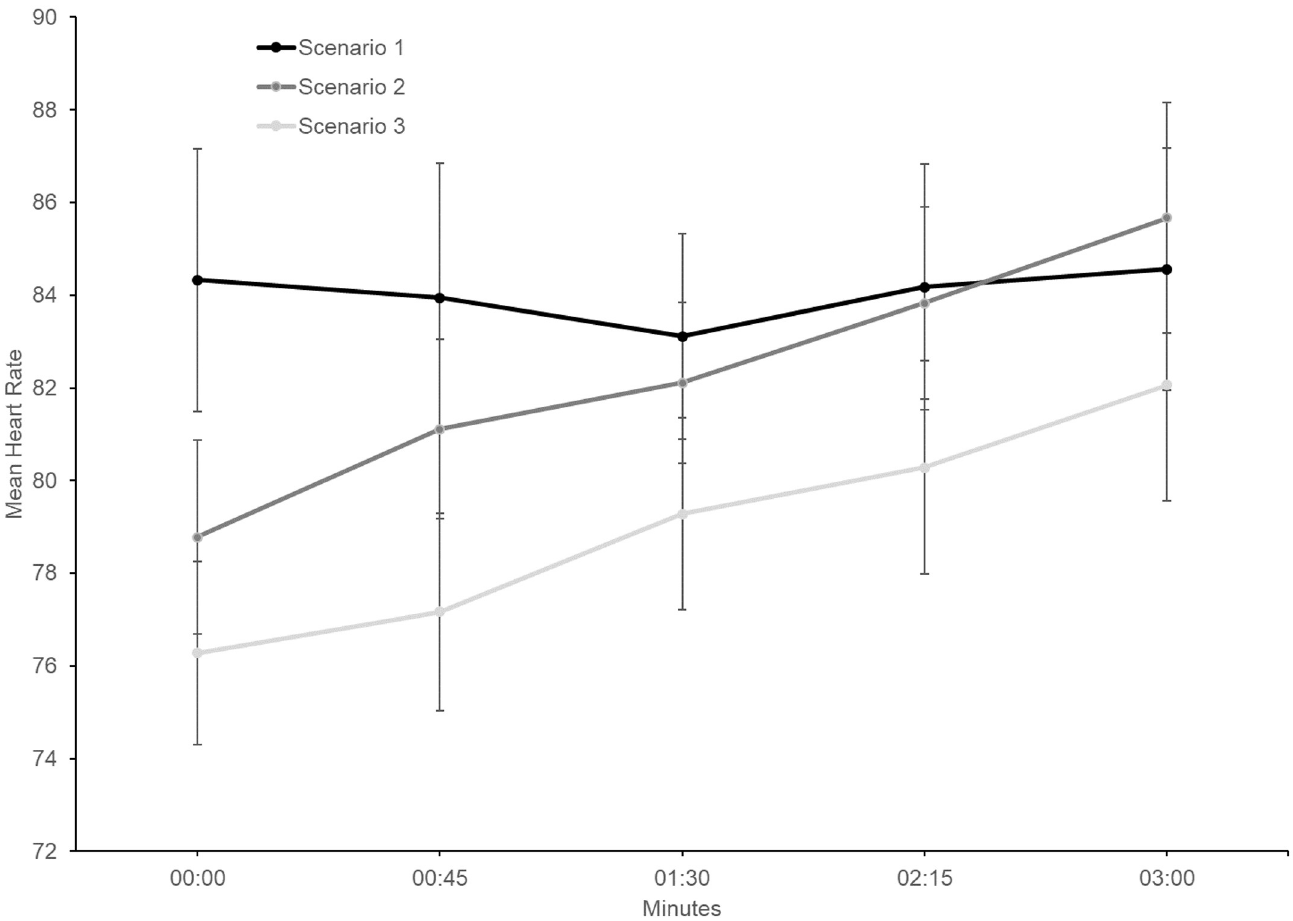
Fig 6. First 3-minutes of within-scenario heart rate mean scores for all scenarios ( N = 18). Error bars represent standard